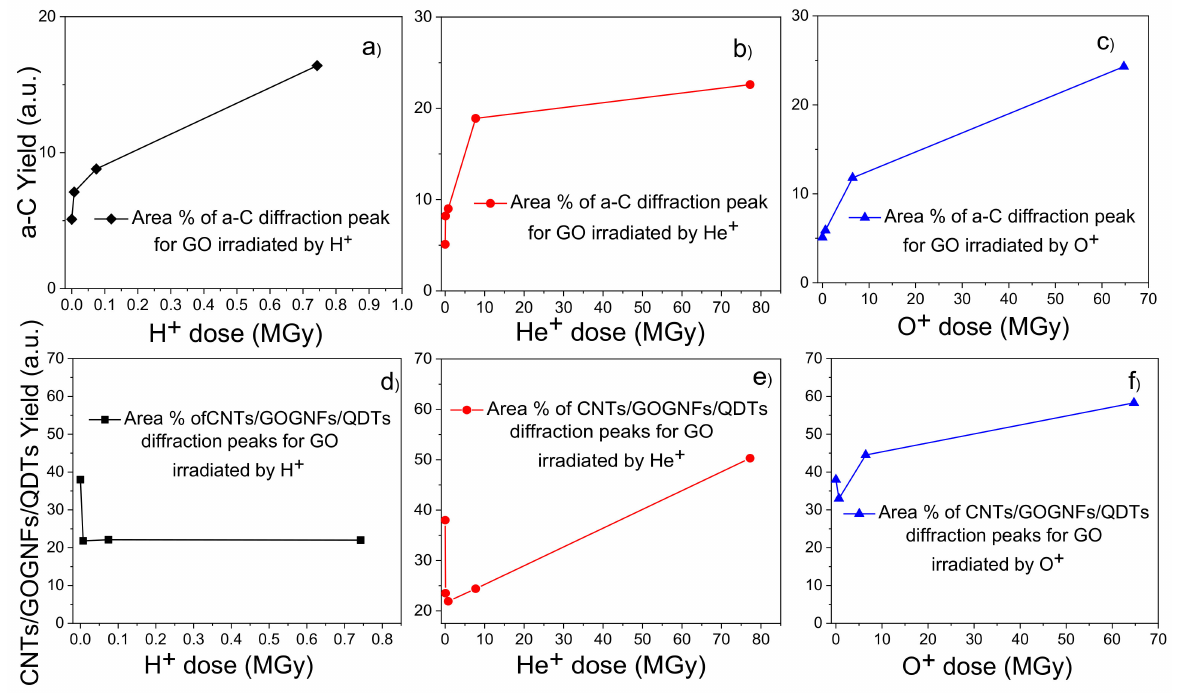
Figure 16. Areas of a-C ( a – c ) and CNTs/GOGNFs/GO QDTs ( d – f ) diffraction peaks vs. the ion absorbed dose for the GO foils irradiated by H + ( a , d ), He + ( b , e ) and O + ( c , f )